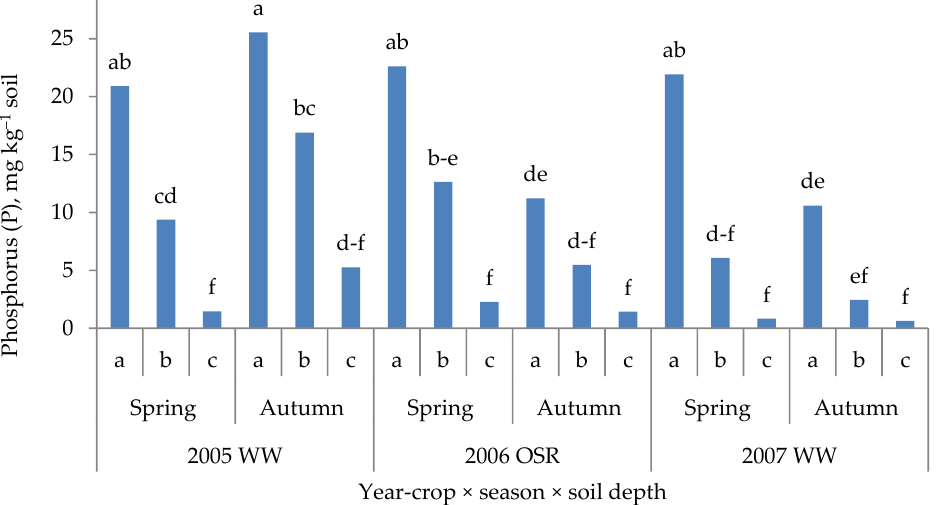
Figure 9. The seasonal patterns of available phosphorus distribution within soil layers (based on Łukowiak et al. [65]). Key: WW—winter wheat, OSR—oilseed rape. Letters indicate significant differences between treatments.